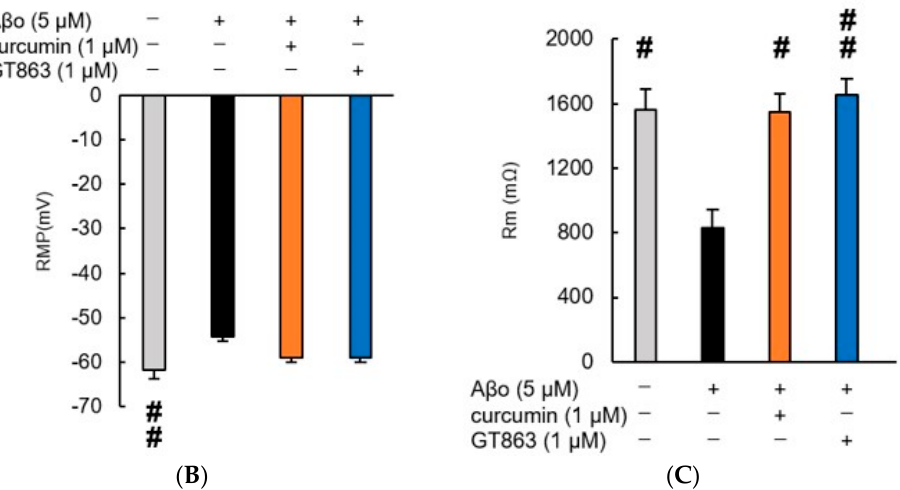
Figure 7. Effect of curcumin and GT863 on cell − membrane potential and electrical resistance of the cell membrane. ( A ) The membrane potential in A β o − stimulated SH − SY5Y cells was evaluated using DiBAC 4 (3). The membrane potential in SH − SY5Y cells exposed to 5 μ M A β o and treated with A β o + 1 μ M curcumin and A β o + 1 μ M GT863 ( n = 4, Tukey’s test). ( B ) Resting − membrane potential was measured in SH − SY5Y cells treated with 5 μ M A β o, curcumin, and GT863 by patch − clamp recording. ## p < 0.01 vs. A β o group. ( C ) Electrical resistance of the membrane was measured in SH − SY5Y cells treated with 5 μ M A β o, curcumin, and GT863 by patch − clamp recording. # p < 0.05 vs. A β o group. ## p < 0.01 vs. A β o group. The p − values in ANOVA were 0.0001. Each value expresses the mean ± S.E.M. of at least 3 independent experiments.